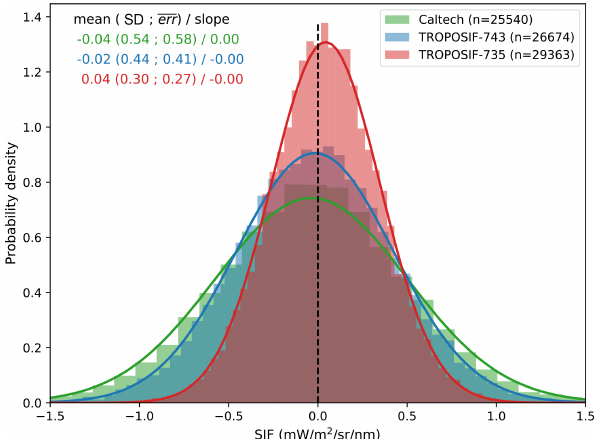
Figure 10. Histogram of all available TROPOMI-based SIF esti- mates at 10 PICS over the 2018–2020 period, for Caltech SIF and TROPOSIF SIF estimates from the 743–758 and 735–758nm fit- ting windows. The distributions were fitted using a Gaussian func- tion; the corresponding mean (bias) and standard deviation (SD) are provided for each SIF product. The mean slope of the SIF temporal variations over the 10 PICS is given in